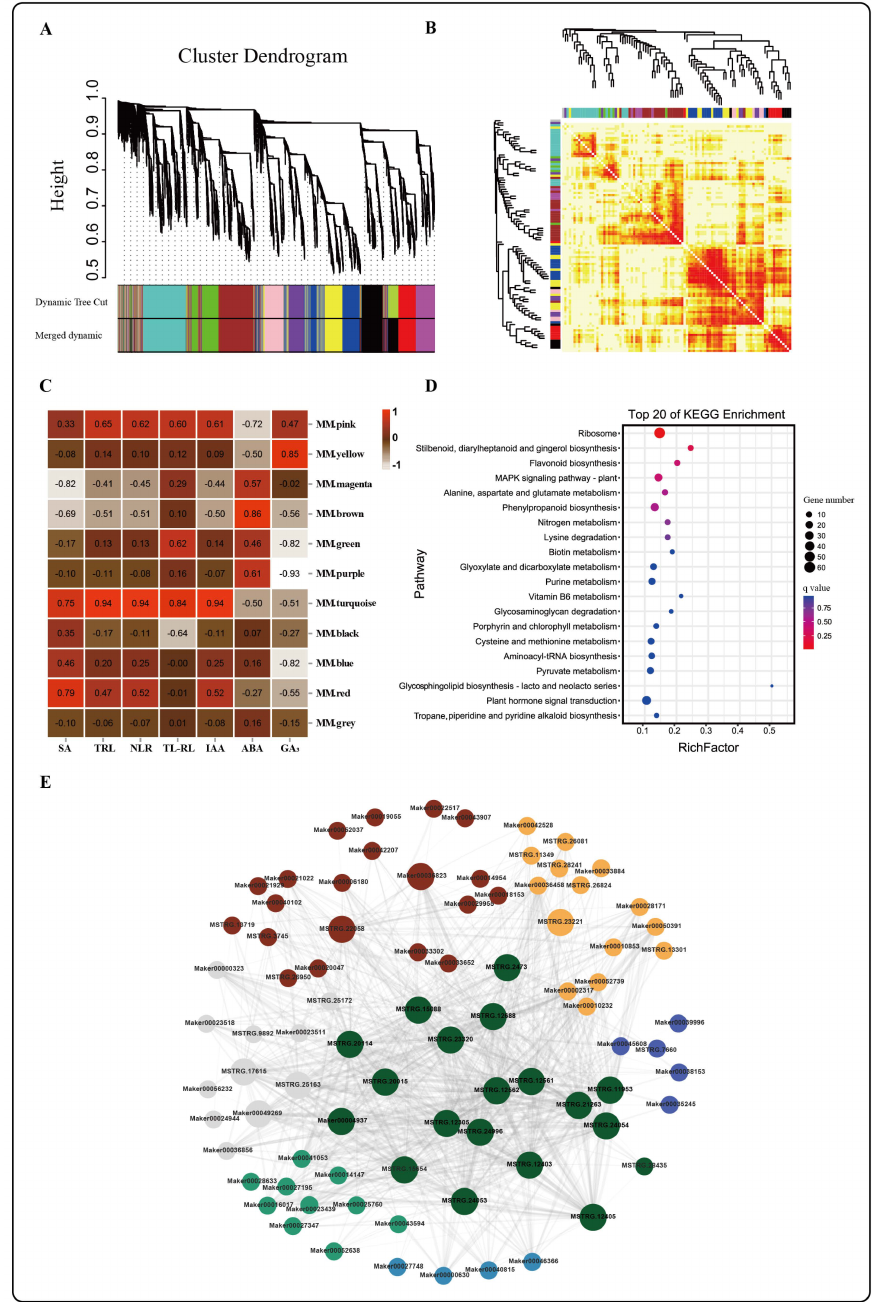
Figure 4. ( A ) Topological overlap matrix (TOM) heatmap showing the correlation among gene module memberships in the root of P. bournei . ( B ) Average linkage hierarchical clustering dendrograms of the genes. Modules, designated by color code, are the branches of the clustering tree. ( C ) Correlation analysis between a module and P. bournei treated by different concentrations of PBZ. The number of each cell is the correlation coefficient between each module gene and treated sample, and the colors of squares from red to white indicate the corresponding p -value ( p < 0.05). ( D ) Significantly enriched KEGG pathways in the turquoise module. ( E ) Network regulation of the genes of interest. The hub genes are highlighted by the larger circle; the genes about root growth are gray; auxin, abscisic acid, and gibberellin-related genes are marked in red, turquoise, and cyan, respectively; transcriptions associated with the root are yellow and slate blue. SA, Total surface area, TRL, Total root length, NLR, number of lateral roots, TL-RL, Total length of the lateral